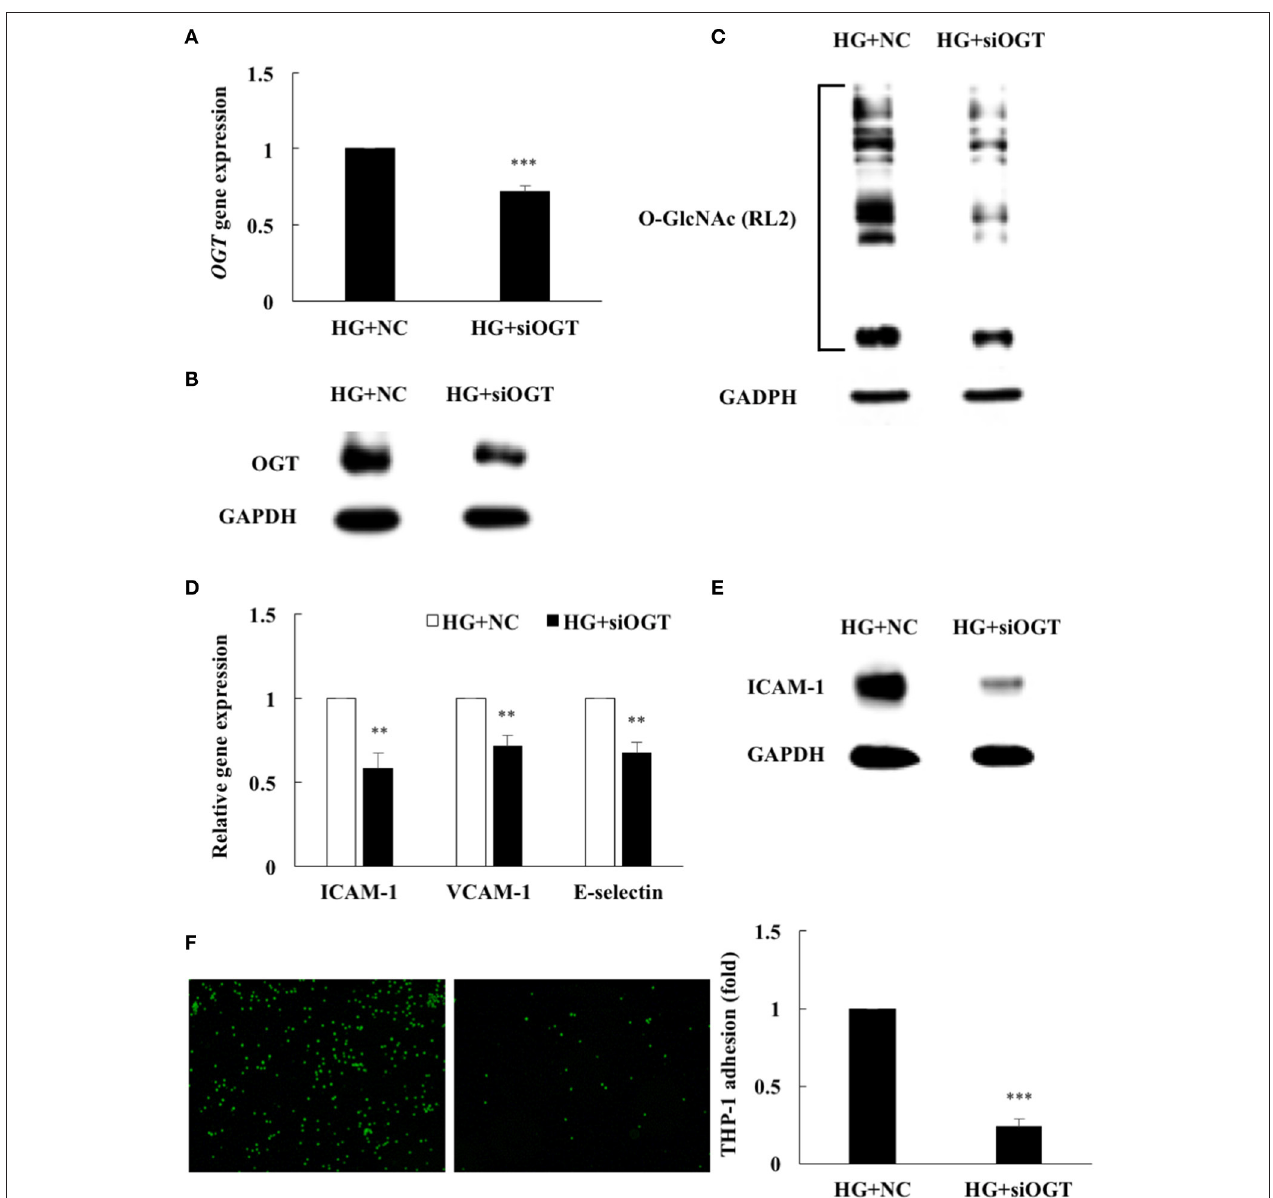
FIGURE 4 | HG-induced endothelial protein O-GlcNAcylation and inflammation were reduced by OGT siRNA transfection. (A) OGT gene expression levels were reduced to 72% of the control level by OGT siRNA in HG-stimulated HAECs (HG + siOGT) N = 5. *** p < 0.001 compared with HG-treated HAECs transfected with negative control (HG + NC). (B) OGT protein expression levels were significantly reduced by OGT siRNA in HG-stimulated HAECs, as compared with HG + NC. The blot is representative of three independent experiments. (C) Protein O -GlcNAcylation levels were significantly reduced by OGT siRNA in the HG-stimulated HAECs, as compared with HG + NC. The blot is representative of three independent experiments. (D) siOGT transfection inhibited HG-induced endothelial ICAM-1 mRNA expression to 58%, VCAM-1 mRNA expression to 71%, E-selectin mRNA expression to 67% of the control level in the HG-stimulated HAECs N = 5. ** p < 0.01 compared with HG + NC. (E) ICAM-1 expression levels were significantly reduced by OGT siRNA in HG-stimulated HAECs, as compared with HG + NC. The blot is representative of three independent experiments. (F) siOGT transfection inhibited HG-induced THP-1 adhesion to 24% of the control level in the HG-stimulated HAECs N = 3. *** p < 0.001 compared with HG +